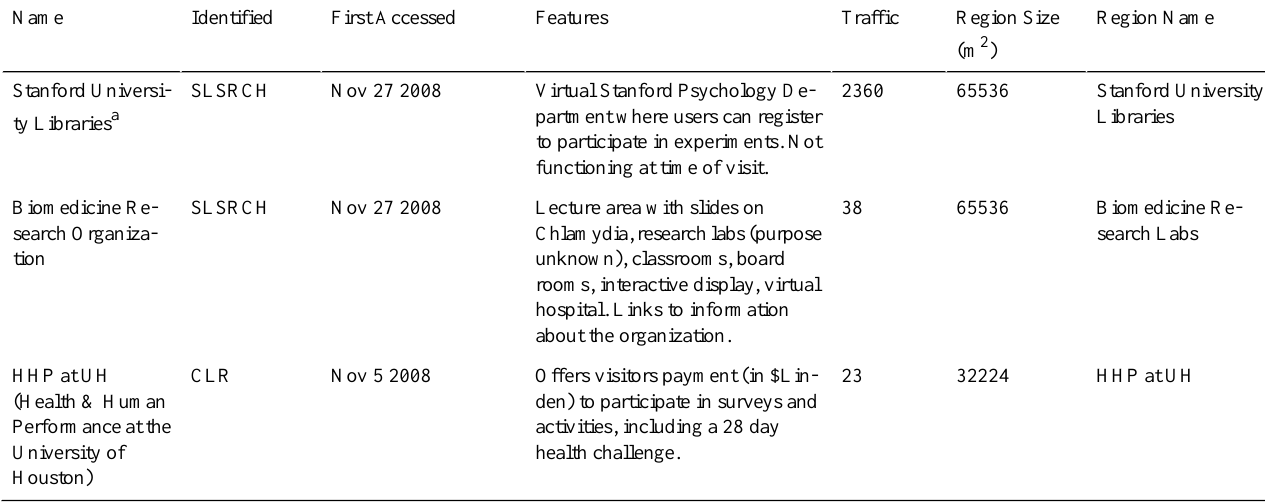
Table 6. Health research sites (ranked by